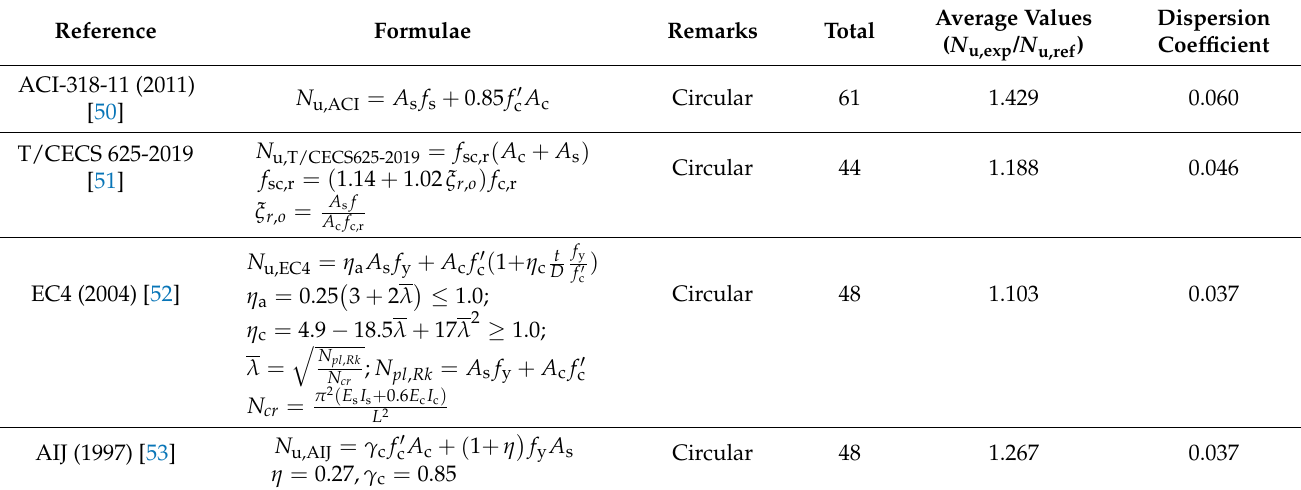
Table 5. Summary of available formulae in other scholars’ literature.